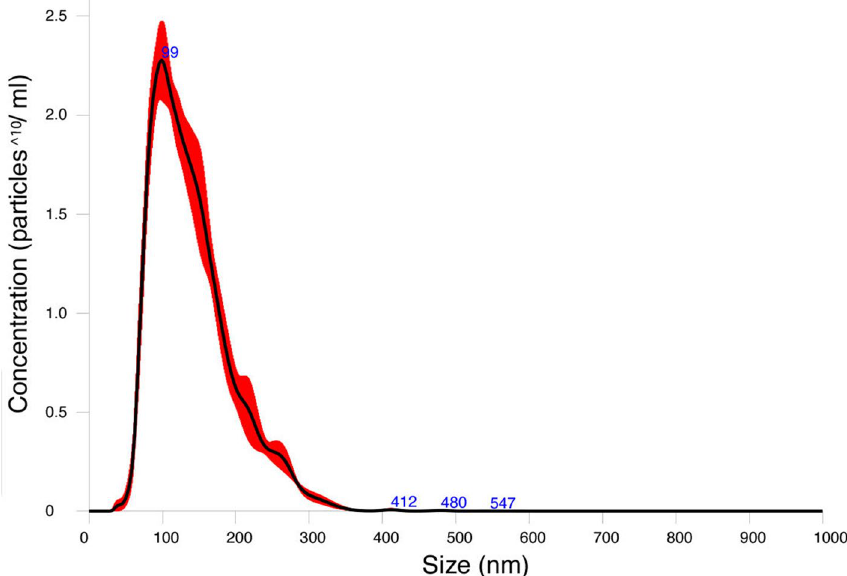
Figure 1. Finite track length adjustment (FTLA) Concentration/Size image for Nanoparticle Tracking Analysis (NTA) of extracellular vesicles secreted by third stage larvae of A. pegreffii